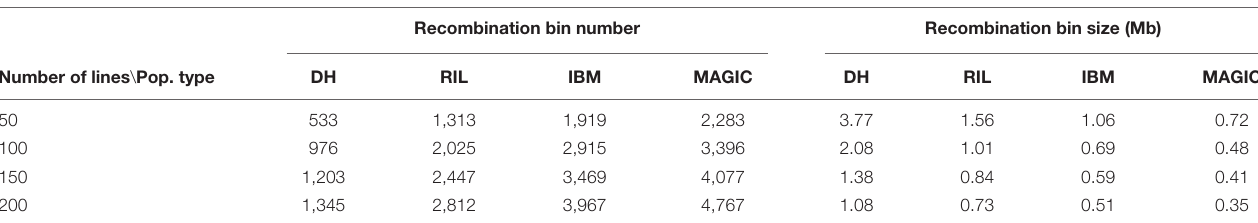
TABLE 3 | Variance of recombination bin number and size in four types of segregating population. Recombination bin number Recombination bin size (Mb) Number of lines \ Pop. type